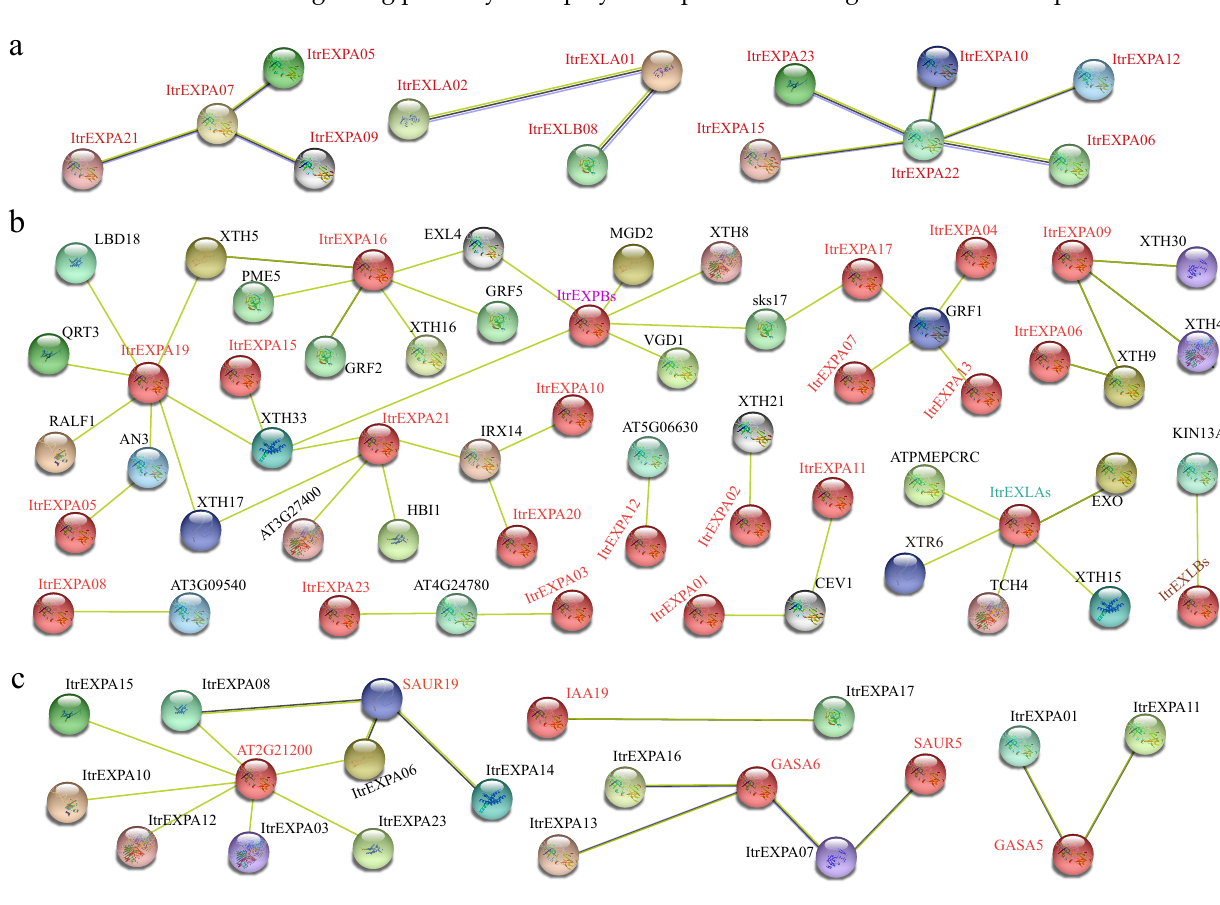
Figure 5. The potential interaction network of ItrEXPs. ( a ) The potential interaction network be- tween ItrEXPs. ( b ) The potential interaction network between ItrEXPs and development related proteins. ATPMEPCRC, putative pectinesterase/pectinesterase inhibitor 26; AN3, arabidopsis grf1- interacting factor 1; CEV1, cellulose synthase a catalytic subunit 3; GRF5, growth-regulating factor; HBI1, basic helix-loop-helix (bhlh) DNA-binding superfamily protein; IRX14, nucleotide-diphospho- sugar transferases superfamily protein; LBD18, LOB domain-containing protein 18; RALF1, rapid alkalinization factor 1; sks17, SKU5 similar 17; XTH, xyloglucan endotransglucosylase/hydrolase protein; AT3G09540, AT3G27400, AT4G24780, PME5, and QRT3, pectin lyase-like superfamily pro- tein; XTR6, probable xyloglucan endotransglucosylase/hydrolase protein 23; TCH4, xyloglucan endotransglucosylase/hydrolase family protein; EXO, phosphate-responsive 1 family protein; EXL4, exordium like 4; MGD2, monogalactosyldiacylglycerol synthase 2; VGD1, plant invertase/pectin methylesterase inhibitor superfamily; KIN13A, P-loop containing nucleoside triphosphate hydrolases superfamily protein. ( c ) The potential interaction network between ItrEXPs and hormone related proteins. AT2G21200, SAUR15, and SAUR19 belong to SAUR-like auxin-responsive protein family; GASA5, GA-regulated protein 5; GASA6, GA-regulated family protein; IAA19, IAA inducible 1. Lines between proteins represent protein-protein